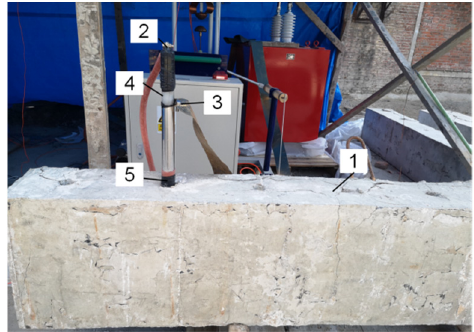
Figure 5. Pulse power breaking test of concrete beam.